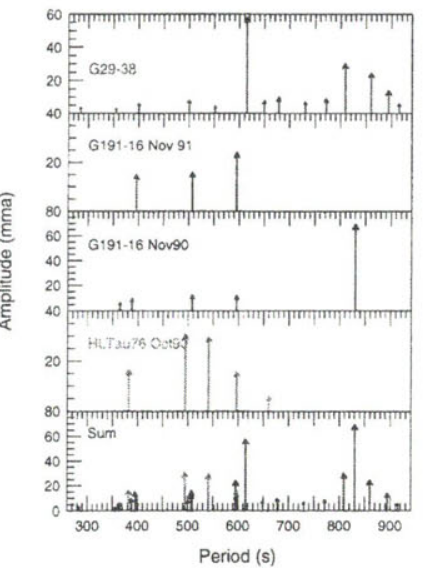
Fig. 20. The non-combination modes of the cool